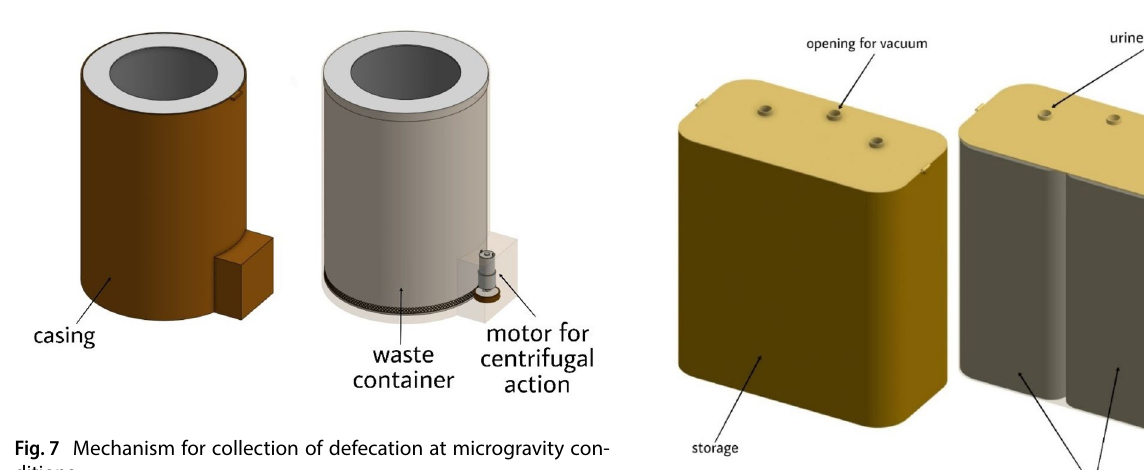
Fig. 7 Mechanism for collection of defecation at microgravity con- ditions